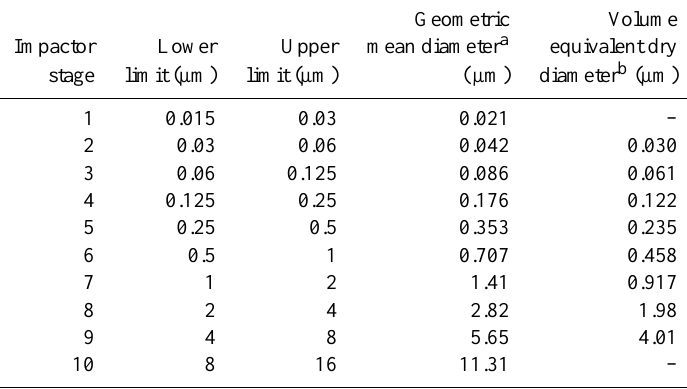
Table 1. Size ranges of the ten-stage Berner low pressure impactor. The lower and upper limits of each stage represent the 50% cutoff aerodynamic diameters.